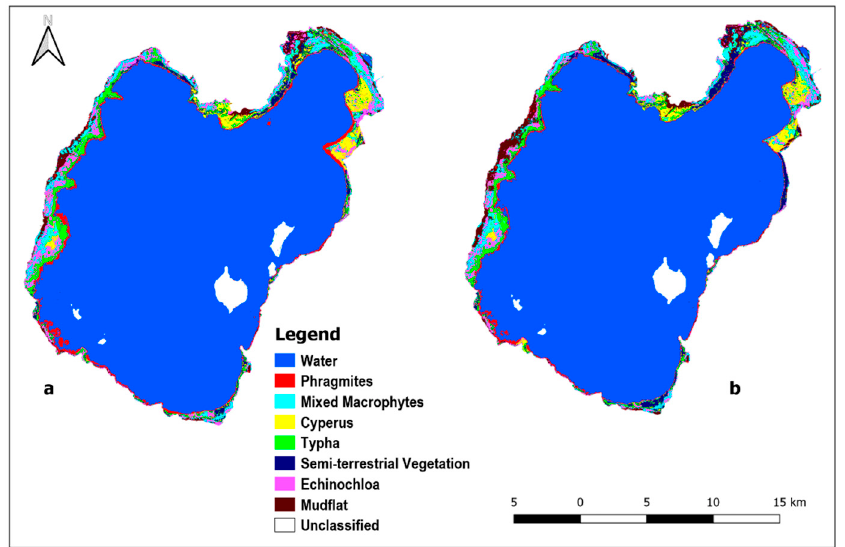
Figure 3. Final classification map using Landsat 8 OLI image from October 2016 based on ( a ) NDAVI and ( b ) NDVI. Table 2. Distribution of dominant emergent macrophytes and other target classes from Lake Ziway and the surrounding based on Normalized Difference Aquatic Vegetation Index (NDAVI) and NDVI classification